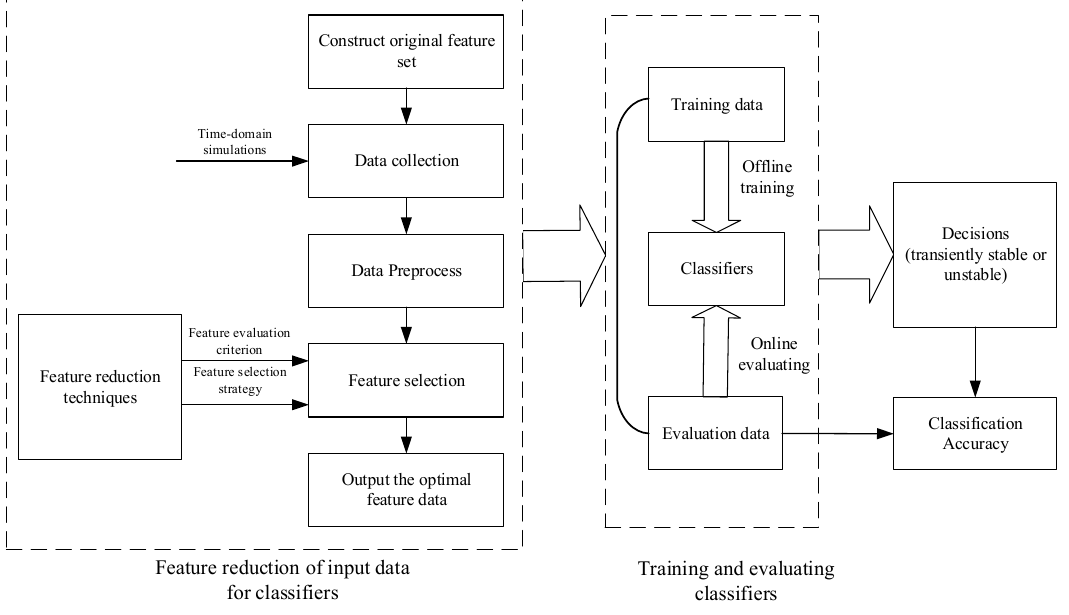
Figure 1. Framework of TSA based on machine learning techniques.